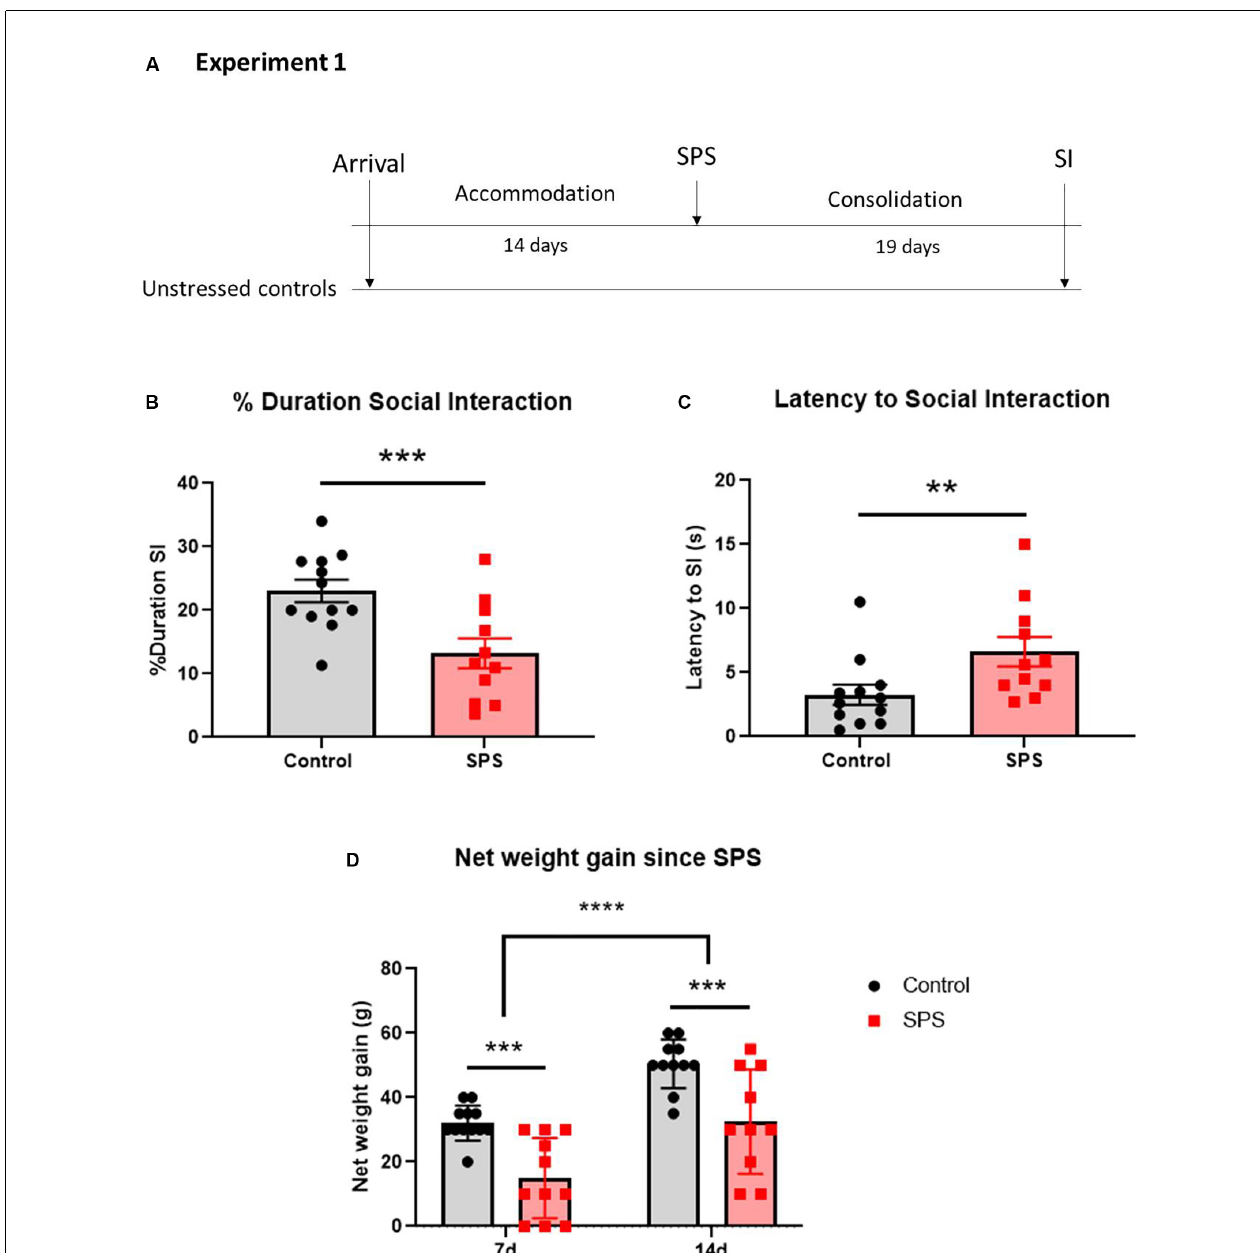
FIGURE 2 | SPS impairs social interaction and weight gain in females. Animals were exposed to SPS stressors and tested for social interaction 19 days afterward, along with unstressed controls (A) . The animals were measured for (B) percent duration engaged in social interaction and (C) latency to the first social interaction encounter. The animals were weighed at 7 and 14 days after SPS and their net weight gain was calculated (D) . Each point represents values for an individual animal. Means ± SEM are shown. Unpaired t -test and two-way repeated measures ANOVA were performed. Šídák’s multiple comparisons test was used to compare the means between groups and time points. ** p < 0.01, *** p < 0.005, **** p < 0.0001.